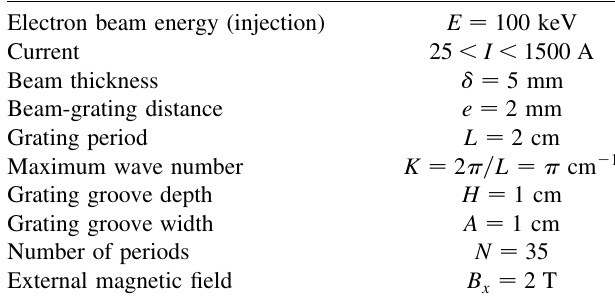
TABLE I. The main parameters of our SP simulation. Electron beam energy